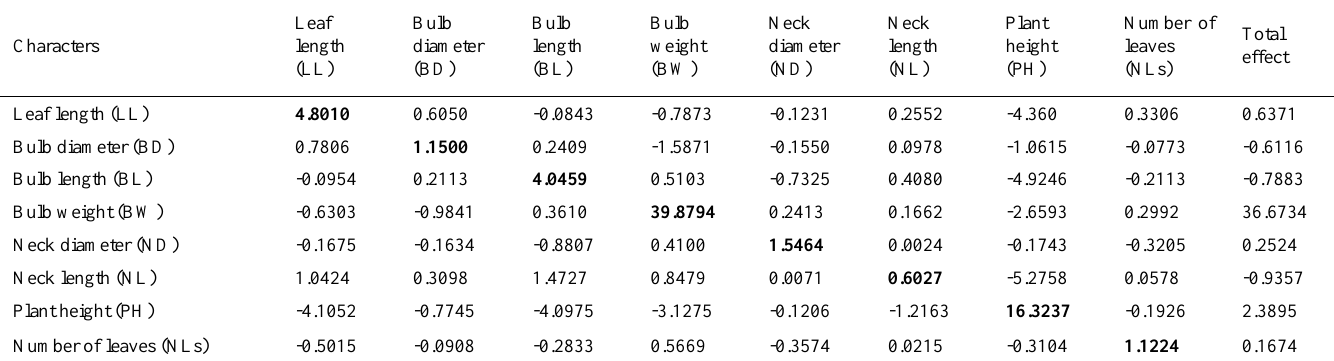
Table 4 . Path coefficient analysis showing direct (bold diagonal) and indirect effects of yield components on bulb yield of onion at phenotypic